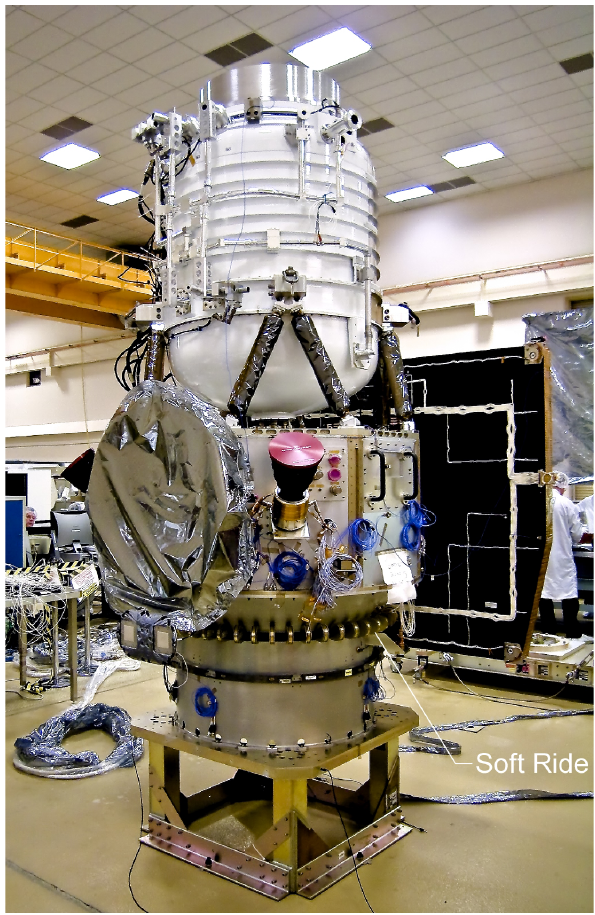
Figure 5. Example of a compliant space mechanism. SoftRide vibration isolation mechanism. The compliant segments separate the launch vehicle adapter and the satellite WISE that was launched on a Delta II in December 2009. Courtesy of U.C.